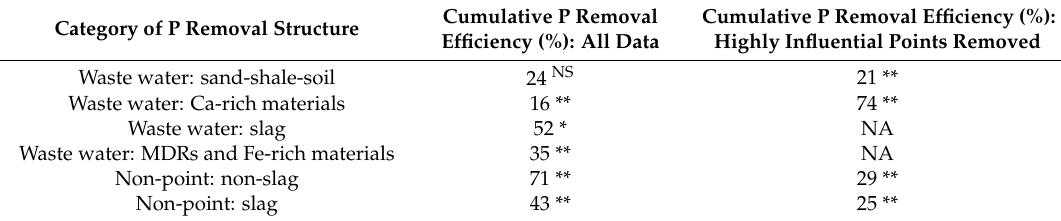
Table 2. Overall phosphorus (P) removal efficiency for each category of P removal structures shown in Table 1 and Figures 3 and 4. Overall removal efficiency is the slope (times 100) of the relationship between cumulative P added and cumulative P removed when the Y-intercept is set to zero. Efficiency is listed for each P-structure category for all data and with removal of highly influential data points, which are indicated as non-filled markers in Figures 3 and